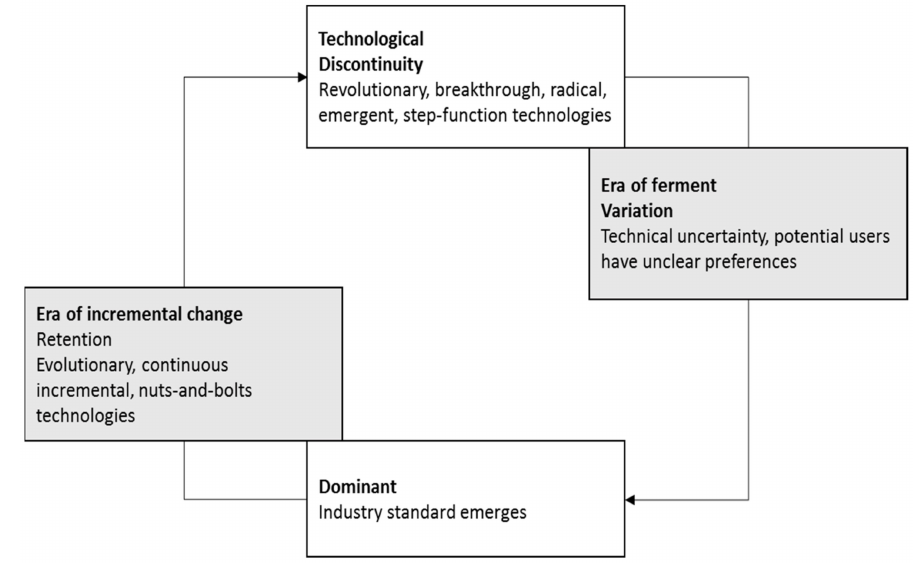
Figure 12. Macro TLC (Adapted from Taylor & Taylor, 2012;